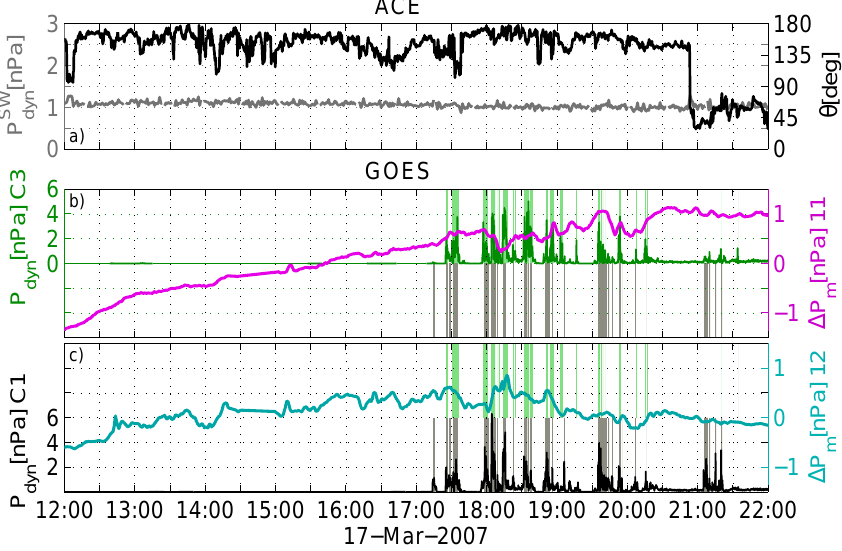
Fig. 7. (a) ACE observations (time-shifted by 44min) of the angle θ between the IMF direction vector and the X GSE -axis and of the solar wind dynamic pressure. (b, c) GOES-11 (magenta) and GOES-12 (cyan) magnetic pressure observations in the magnetosphere in 1-min time resolution. The pressure of the pure dipole field has been removed using the GEOPACK library by N. Tsyganenko. The dynamic pressure at C1 (black) and C3 (green) are displayed in order to indicate the Cluster jet observations. The intervals when the dynamic pressure at C1 (C3) exceeded the solar wind dynamic pressure are in shaded grey (green).